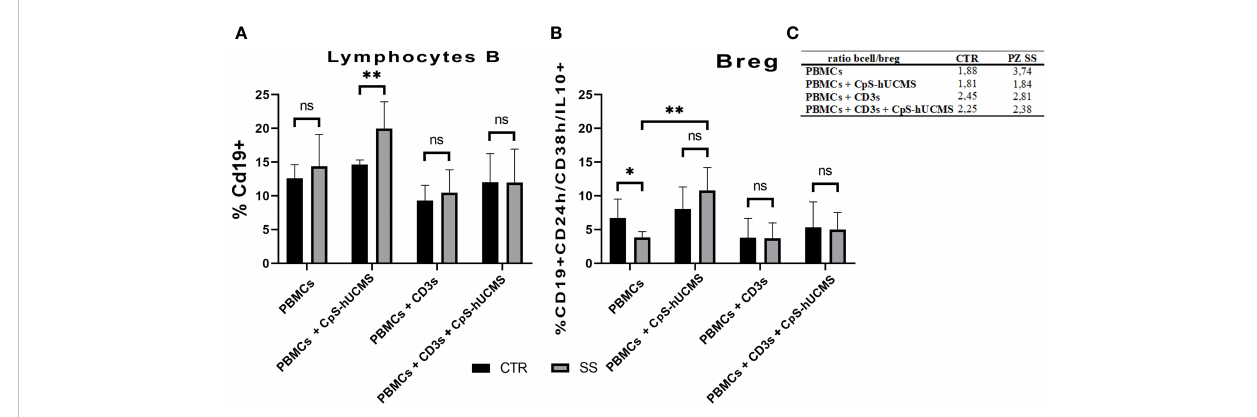
FIGURE 4 (A) Proportion of CD19+ B lymphocytes in PBMCs of healthy subjects (CTRL) and SS patients (SS) in the various conditions (mean ± S.D.; Mann-Whitney T-Test; p<0.005**; ANOVA test in SS; p<0.005** between CpS-hUCMS vs Activated and CpS-hUCMS vs Act. + CpS-hUCMS). (B) Percentage of Breg lymphocytes in the PBMCs of healthy subjects (CTR) and SS patients (SS) in the various conditions (mean ± S.D.; Mann-Whitney T-Test; p<0.5*; ANOVA test in SS; p<0.005** between Medium vs CpS-hUCMS, CpS-hUCMS vs Activate and CpS-hUCMS vs Att. + CpS-hUCMS). (C) B/B-reg lymphocytes ratio in the two groups at various